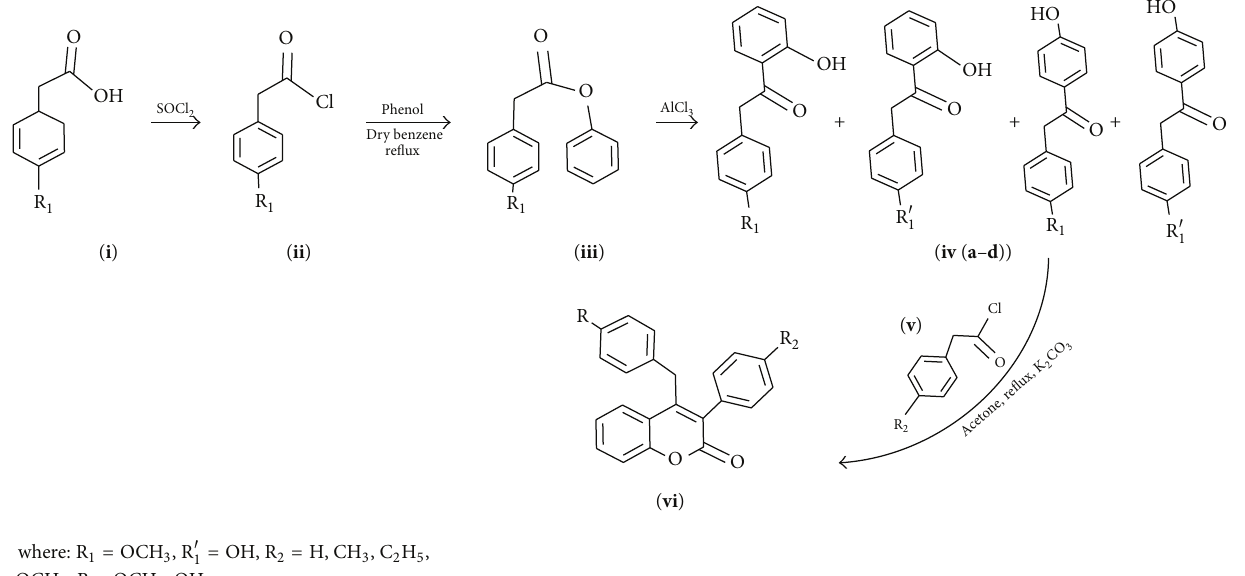
Scheme 1: Route 1 for the synthesis of coumarin based SERM’s precursors.